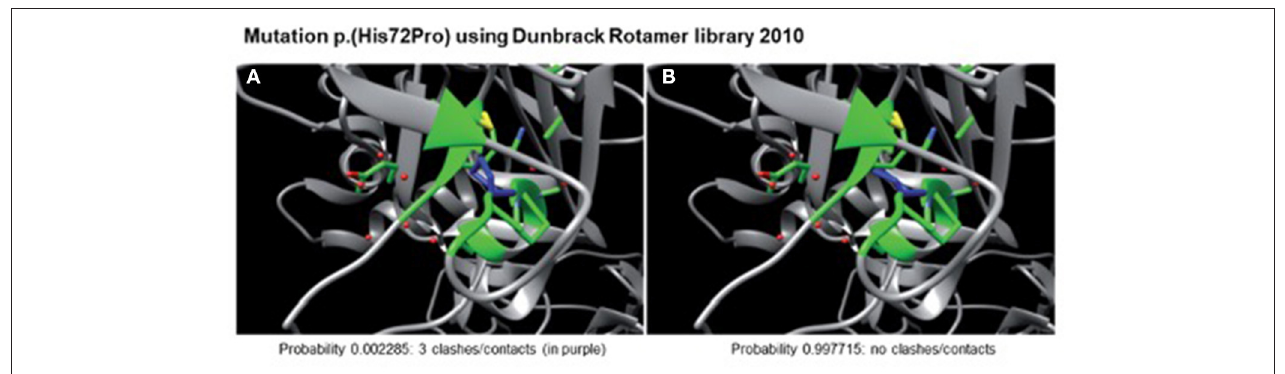
FIGURE 2 | Modeled 3D-structure resulting from c.215A > C in exon 2 of LAMA2. Simulation using the Dunbrack Rotamer library 2010 shows two different 3D conformations of the mutated amino acid (in blue). All neighboring amino acids with a possible interaction with the mutated one are shown in green. Confirmation (A) would produce three clashes and is therefore highly unlikely to occur (calculated probability of 0.002285), whereas confirmation (B) produces no clashes and is therefore the preferred confirmation (probability of 0.997715) leading to no alterations in protein structure.